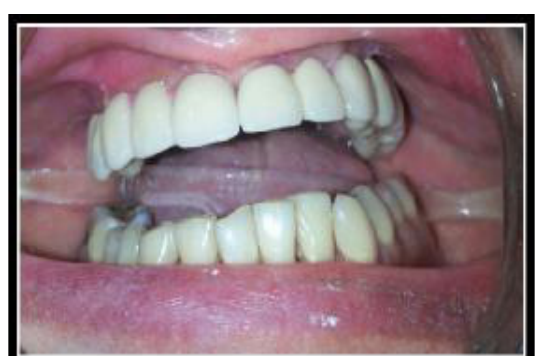
Figure 10: Final Prosthesisinside the Patient’s